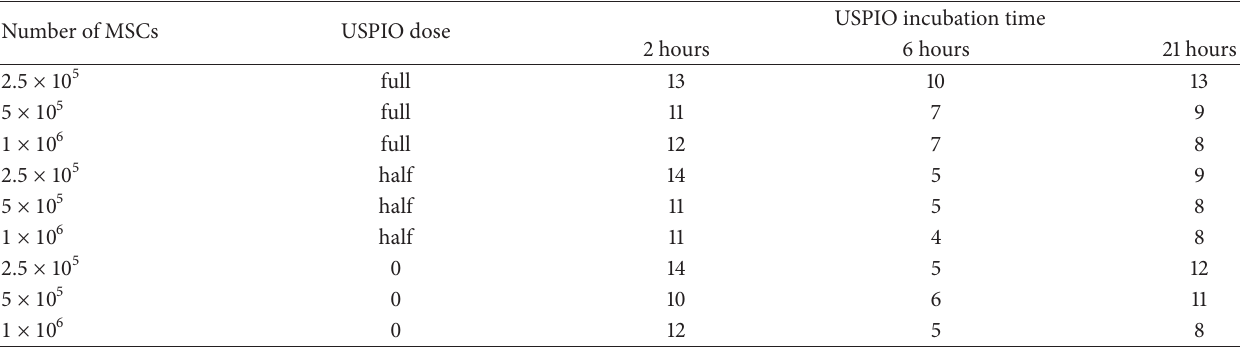
Figure 1: MRI phantoms. (a) Two phantoms containing USPIO labeled cells. (b) MRI image of 2 phantoms with an ellipsoid region of interest placed in the upper phantom. USPIO: ultrasmall superparamagnetic iron-oxide. Table 1: Number of MRI